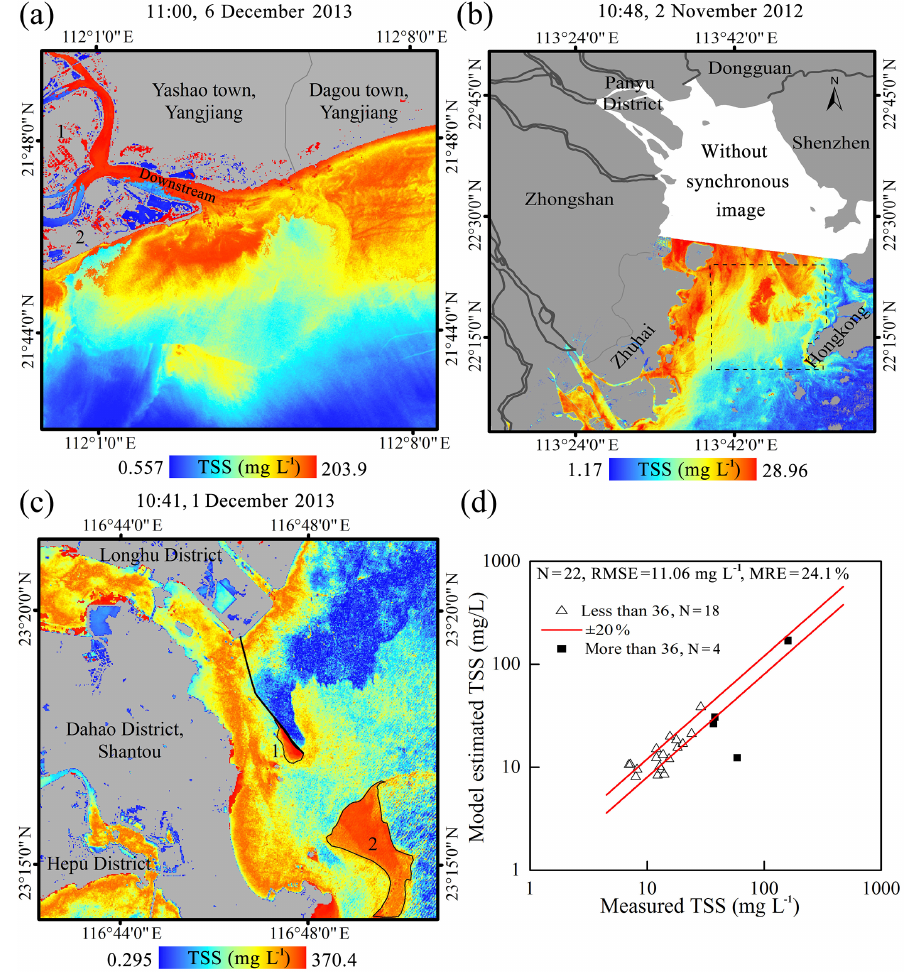
Figure 7. Estimated TSS concentrations based on the QRLTSS model in Moyangjiang River estuary at 11:00 (LT, OLI) on 6 December 2013 (a) , Pearl River estuary at 10:48 (LT, ETM + ) on 2 November 2012 (b) , Hanjiang River estuary at 10:41 (LT, OLI) on 1 December 2013 (c) , and comparison between the in situ measured and Landsat imagery inversed TSS concentrations of three estuaries (d) . Color scale is the legend of the TSS concentrations, in milligrams per liter (mgL − 1